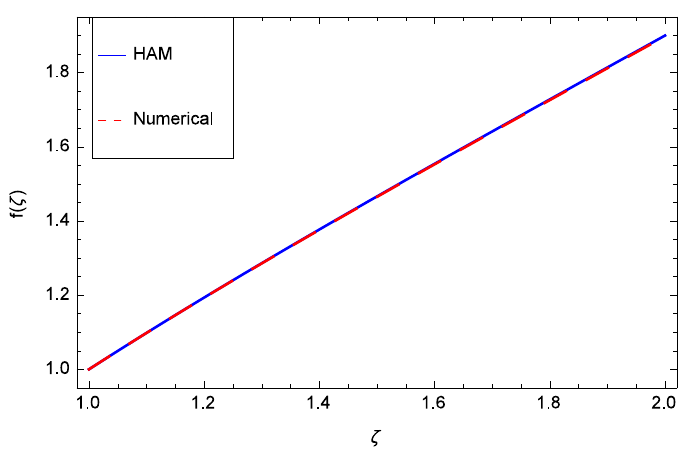
Figure 18. Comparison of the velocity solution of HAM with numerical method solution when h = − 0.55, β 1 = 2.00, M = 0.10, Re = 0.70, φ = 0.04, Pr = 1.10 for (CuO-H 2 O).